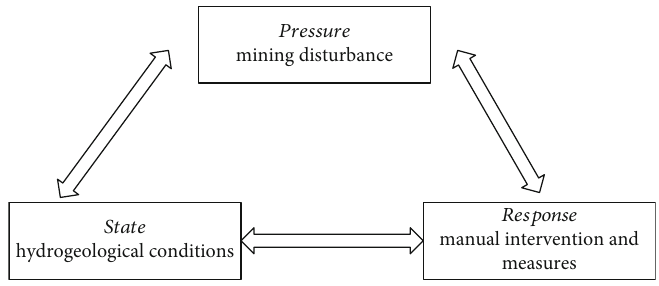
Figure 1: PSR framework to assess coal fl oor water